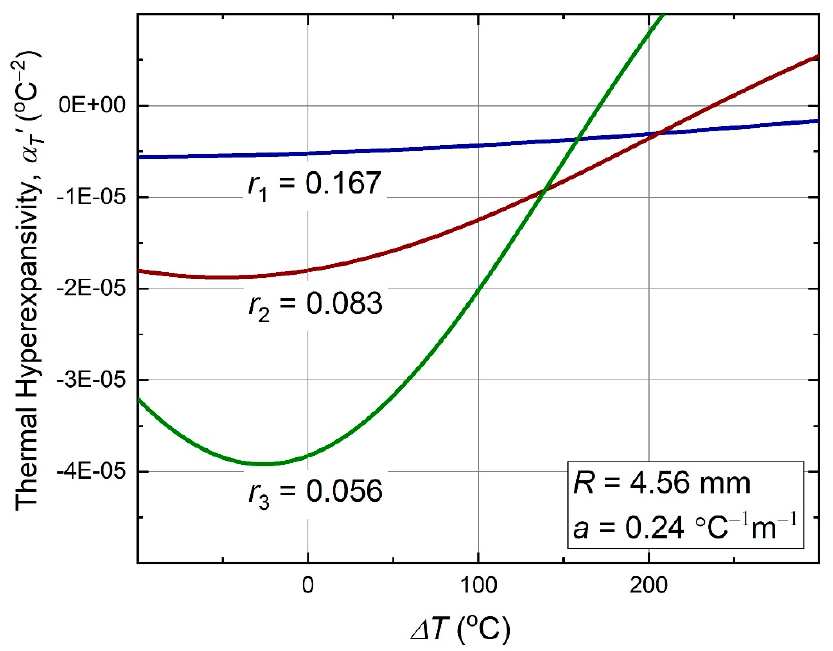
Figure 6. Thermal hyperexpansivity (11) of the antichiral metamaterial as function of temperature.